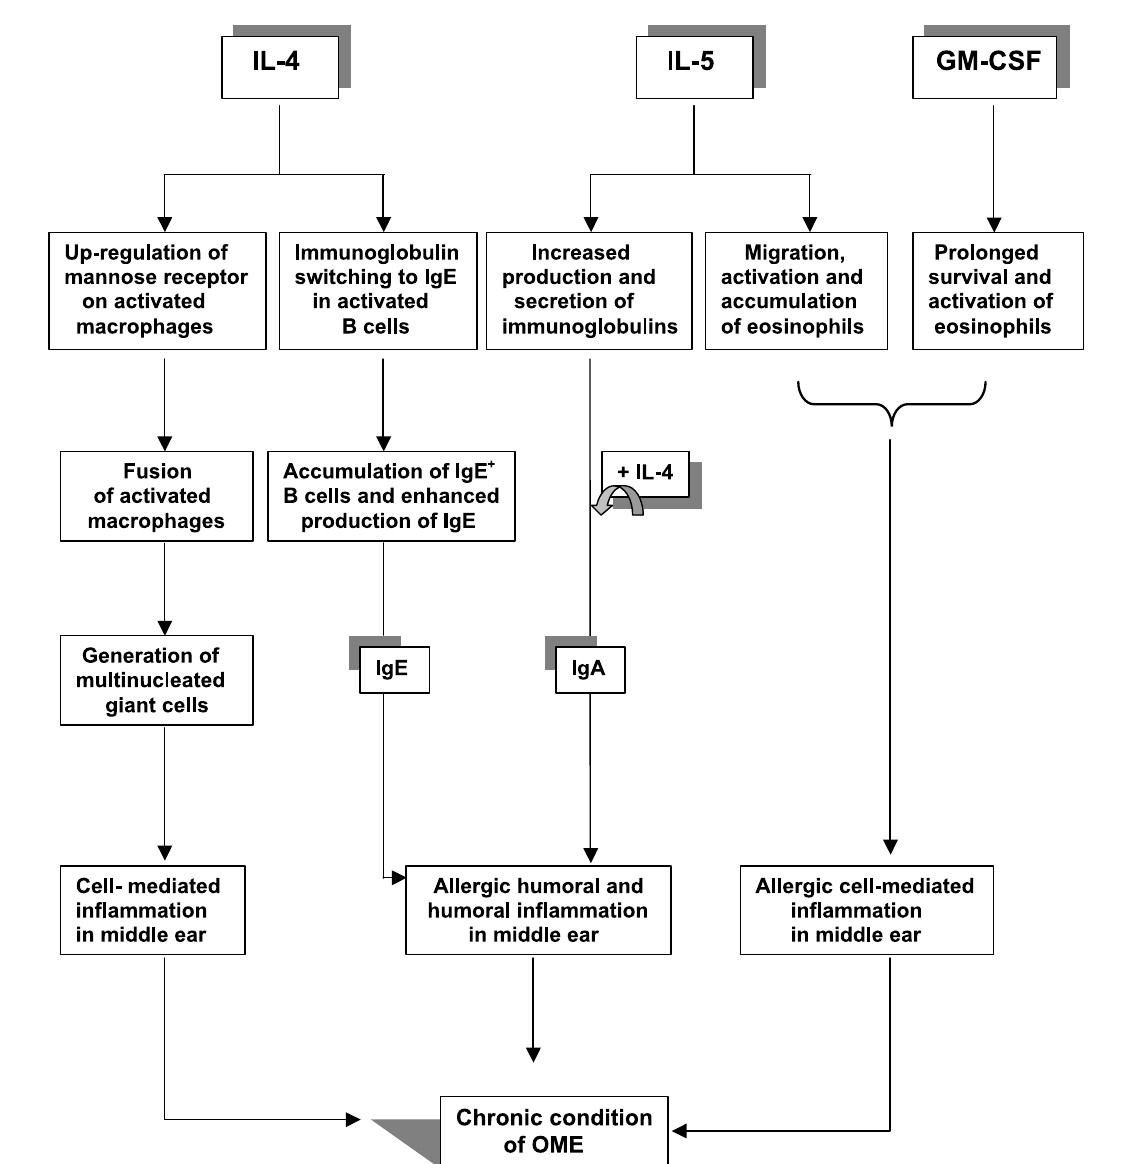
FIG. 6. Cellular and molecular networks of the allergy-associated cytokines leading to the chronic condition of